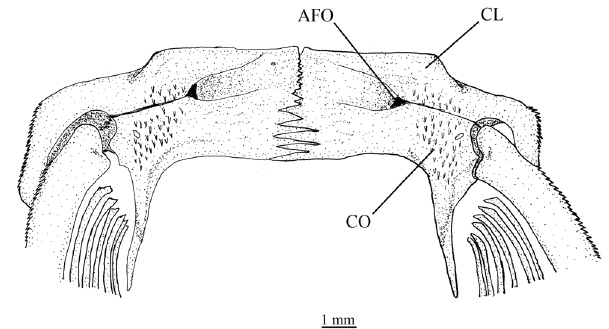
Fig. 4. Ventral view of pectoral girdle of Parotocinclus seri- doensis , UFRN 005, 30.7 mm SL, female . Abbreviations: AP, abdominal plates; AFO, arrector fossa opening; CL, cleithrum; CO,